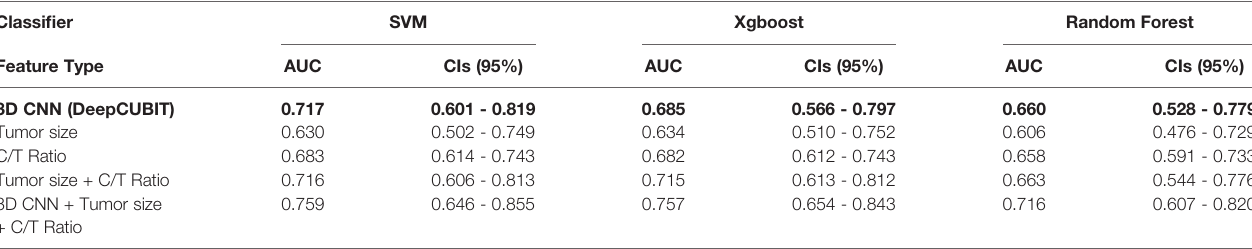
CNN, Convolutional Neural Network; DeepCUBIT, Deep Cubical Nodule Transfer Learning Algorithm; C/T Ratio, consolidation to tumor ratio; SVM, Support Vector Machine; AUC, area under the curve; CIs, Con fi dence Intervals for AUC score. Variable with DeepCUBIT model is shown in bold type.